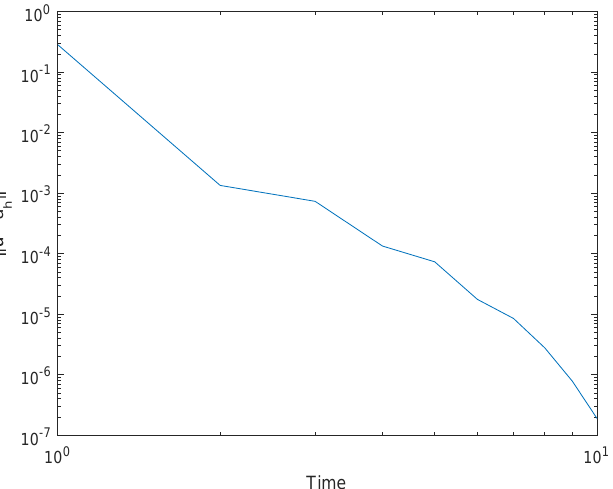
Figure 3. The behavior of the error (cid:107) u n − u n Experiment 3.